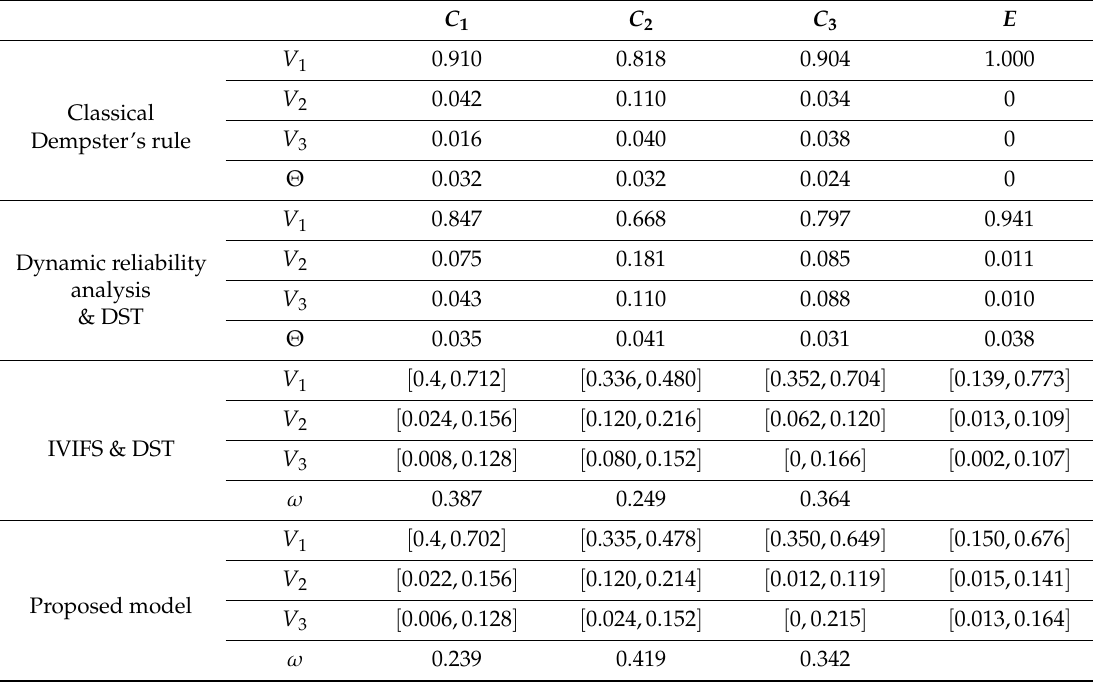
Table 5. The fusion results of di ff erent decision models. C